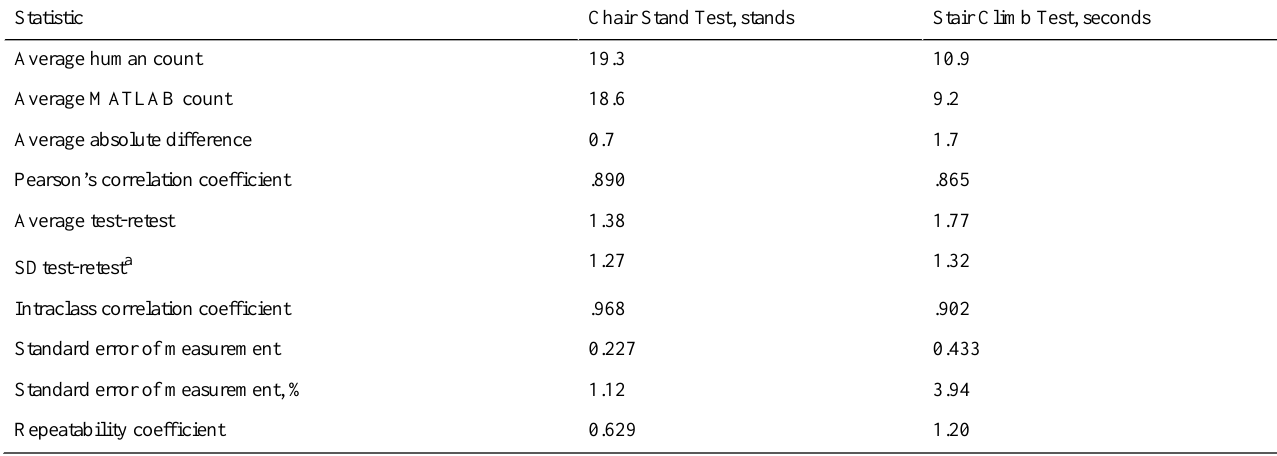
Stair Climb Test, secondsChair Stand Test,